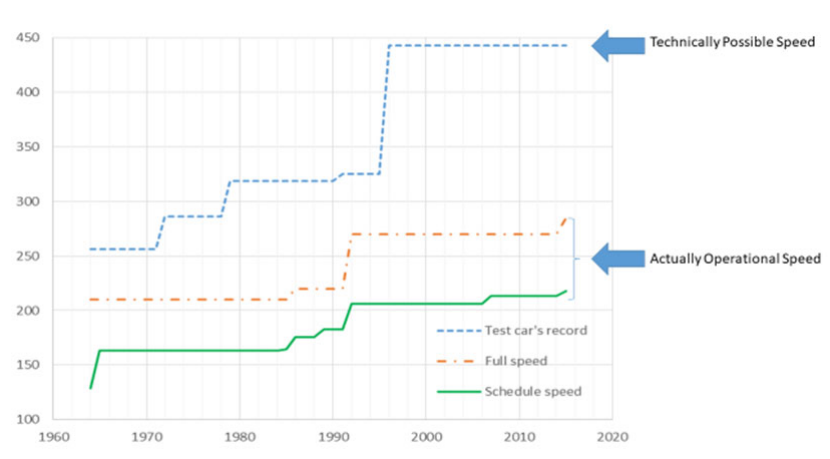
Figure 1. The transition of Shinkansen speed Source: Kikuchi (2016), Figure